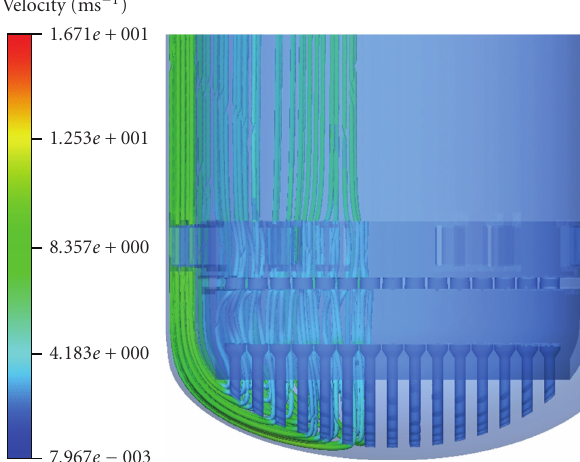
Figure 6: Stream lines in the lower plenum